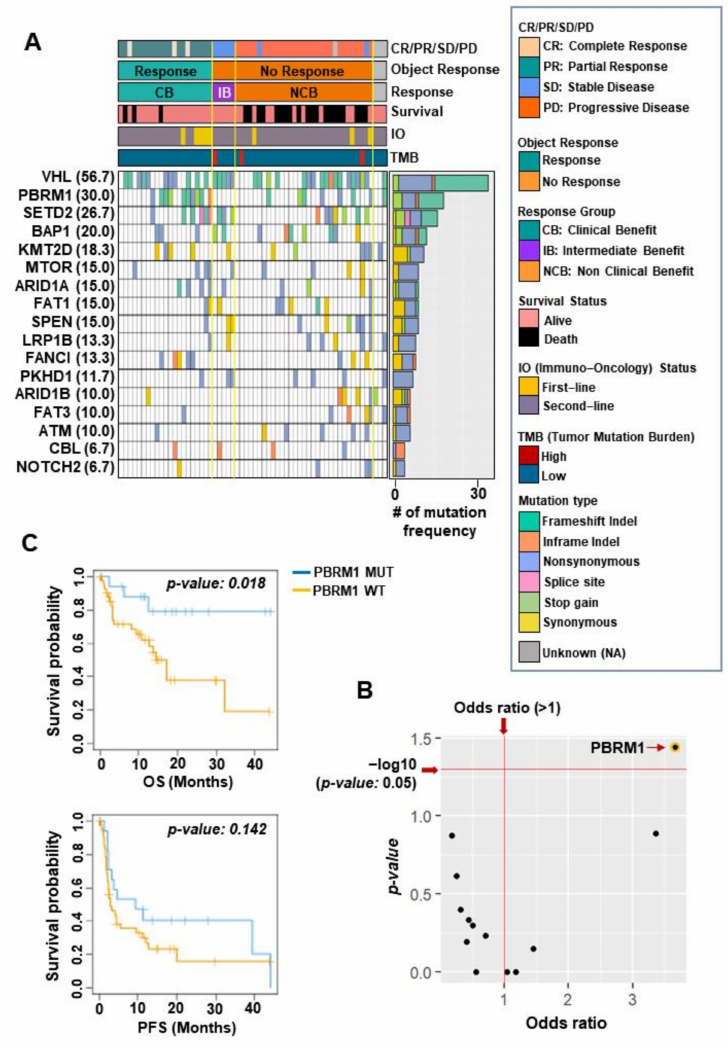
Figure 1. Overall mutational landscape in 60 patients with metastatic clear cell carcinoma treated with immune checkpoint inhibitors. ( A ) Heatmap shows 17 recurrently mutated genes in our cohort ordered by the number of mutation frequencies. ( B ) The plot shows the p -value and odds ratio for the 17 genes by performing Fisher’s exact test between the clinical benefit versus non-clinical benefit groups. (Red dashed lines denote p < 0.05 and odds ratio > 1. Each black dot denotes the 17 recurrently mutated genes). ( C ) Kaplan–Meier plots show the overall survival (top) and progression-free survival (bottom) of patients who did or did not harbor mutations in PBRM1 . PBRM1 MUT, PBRM1 mutation (blue); PBRM1 WT, PBRM1 wild type